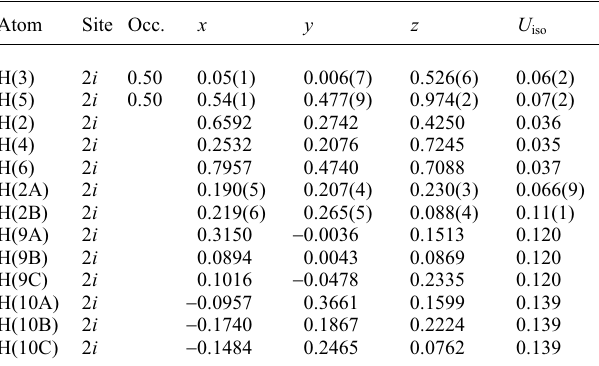
Table 2. Atomic coordinates and displacement parameters (in Å 2 ) . Table 1. Data collection and